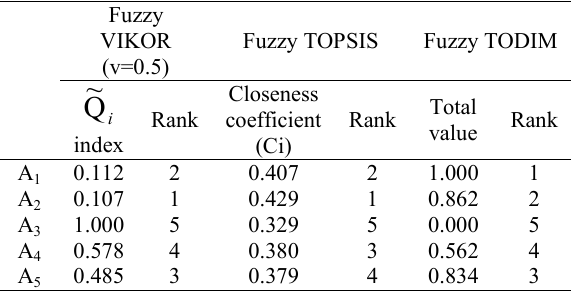
Table 8. Fuzzy VIKOR, TOPSIS and TODIM